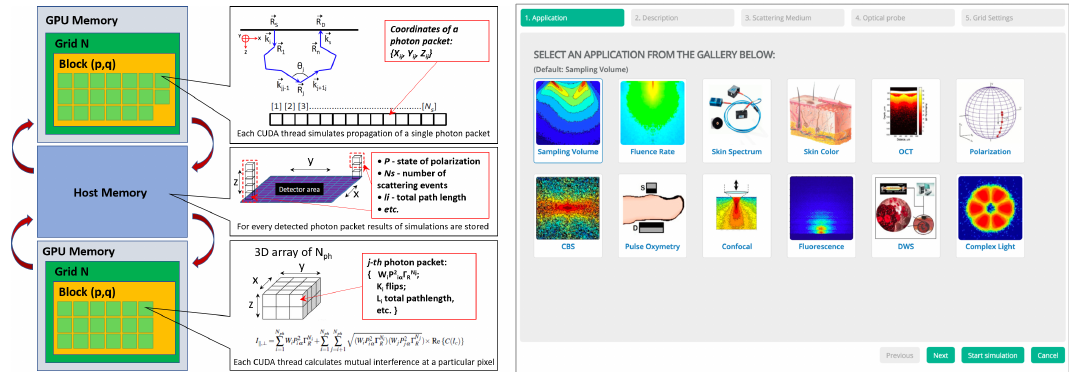
Figure 2. The block-diagram showing the principles of GPU-based computations of the resulting intensity of scattered light and its spatial distribution at the detector area ( left ). Front screen of the online MC tool where each icon is associated with a particular application ( right ), available online at